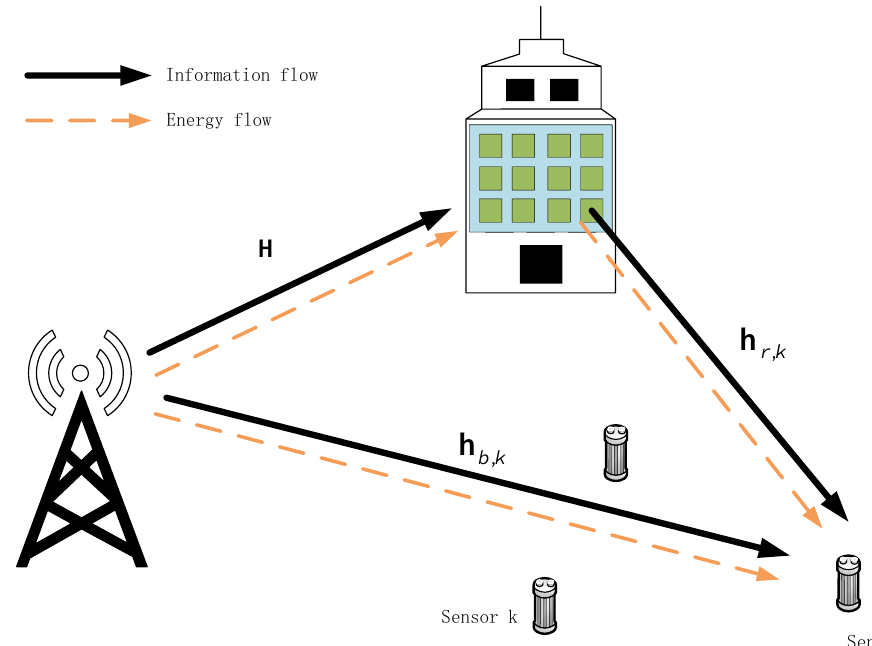
Figure 1. RIS-aided multi-sensor wireless SWIPT